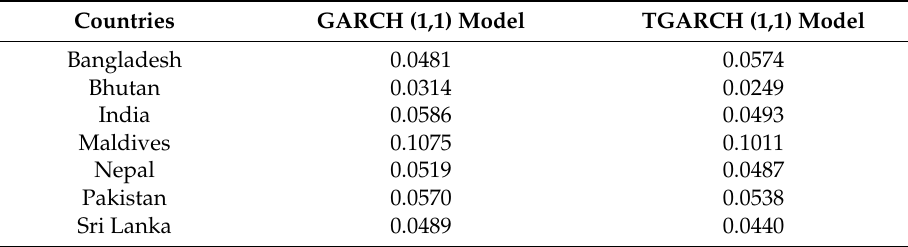
Table 4. Lon-Run Exchange Rate Volatility for the Individual